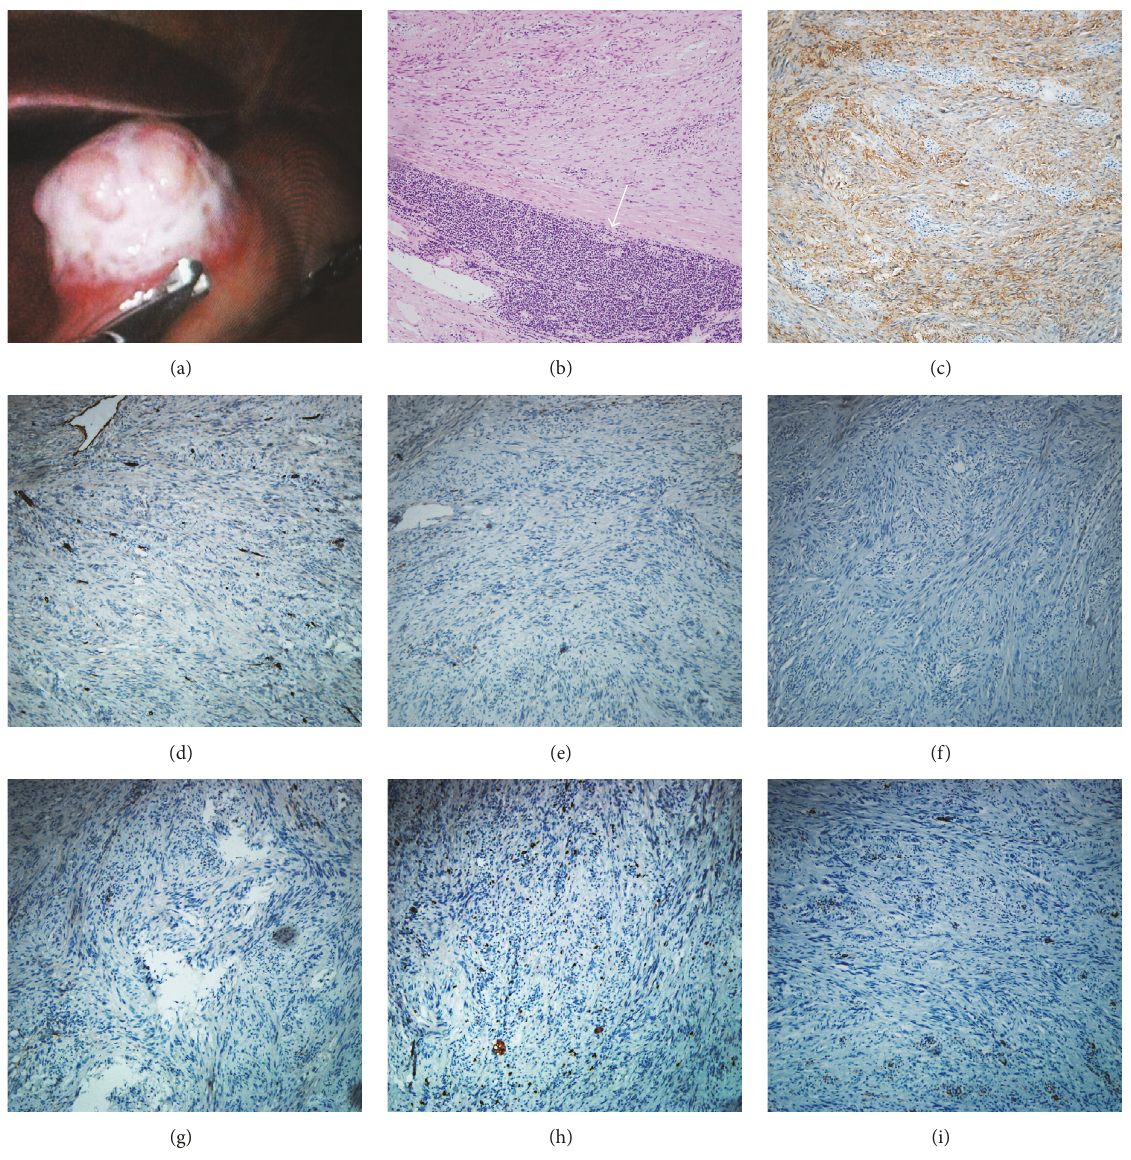
Figure 3: Pathological imaging of the mass. (a) An exophytic tumor with size of 4 × 3 cm arising from the anterior wall of the lesser gastric curvature was observed. The exophytic part of the mass appeared off-white in color and rough with a concavo-convex surface; however, the margin of the mass on the gastric wall was clear. (b) Hematoxylin and eosin staining showed that the mass was composed of palisade- arranged spindle cells and peritumoral cuff-like lymphocytic infiltration (white arrow). (c) Immunohistochemical staining of sections showed that the gastric schwannoma was S-100-positive but was negative for (d) CD34, (e) CD117, (f) desmin, (g) DOG1, (h) Ki-67, and (i) SMA. × 100 magnification for all